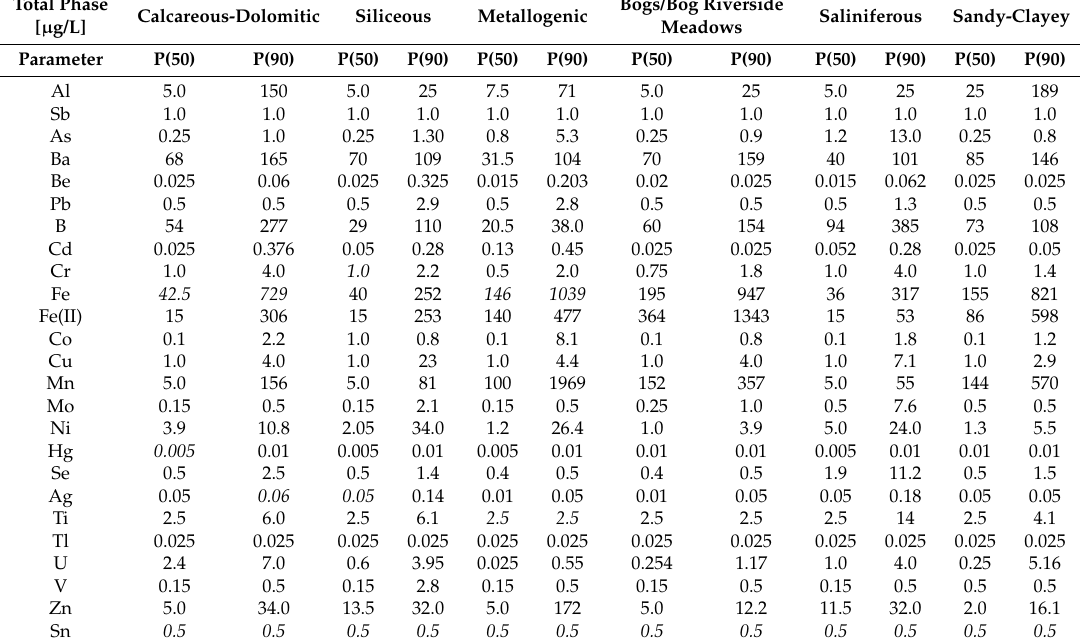
Table 3. Geogenic background concentrations for metals and metalloids in the filtered phase in the rivers of Saxony-Anhalt classified by the aggregated riverine landscapes (preselection of data, 50th and 90th percentiles, for all elements the database is n > 20; italics represent data below the detection limit).